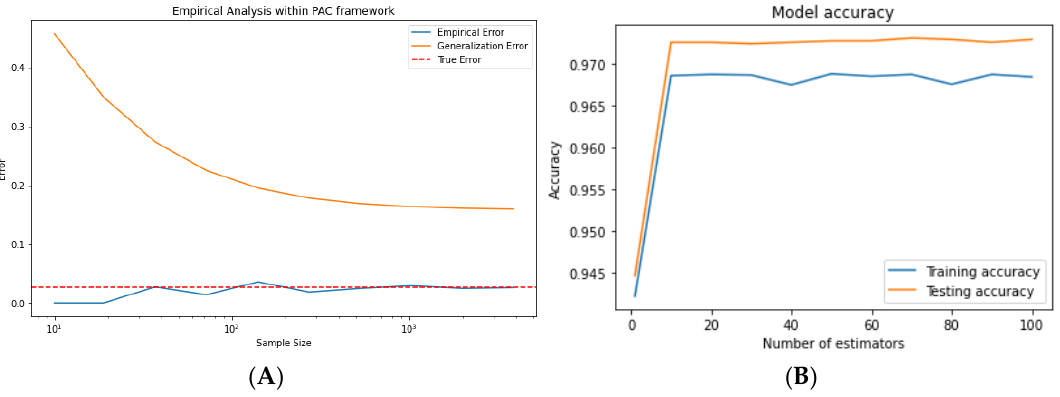
Figure 6. ( A ) The generalization error compared to empirical error and true error of group 2 dataset. ( B ) The model’s accuracy in examining the over-fitting issue in terms of the number of estimators for both training and testing scores combined using group 2 dataset. Table 7. The sample size ranges with minimum and maximum FNRs and FPRs of group 2 dataset combined with PAC